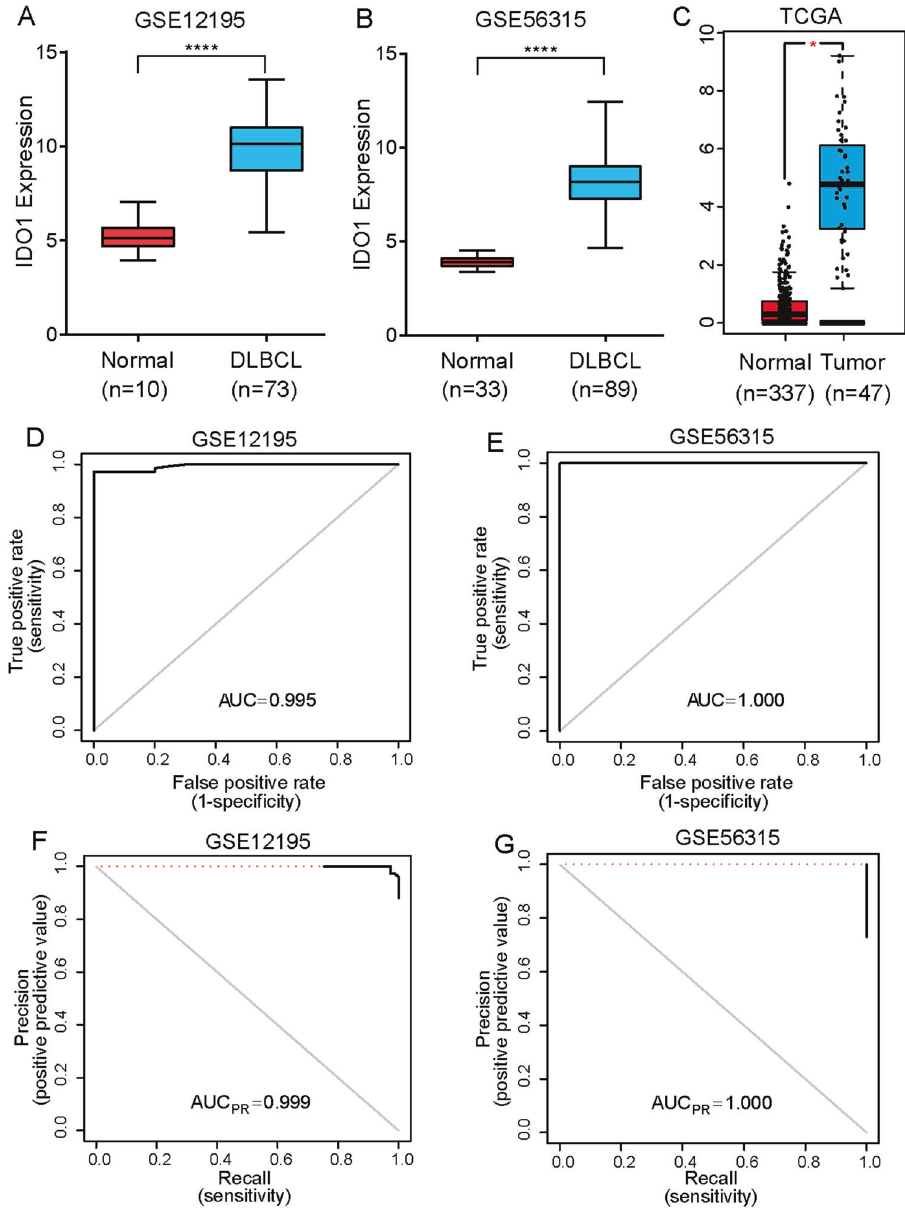
Fig. 1 DLBCL datasets revealed that IDO1 was overexpressed in DLBCL and could be a predictive marker for DLBCL. A – C IDO1 expression in DLBCL and normal tissues from GSE12195 ( A ), GSE56315 ( B ), and TCGA DLBCL ( C ). D , E Receiver operating characteristic (ROC) curves calculated the sensitivity and speci fi city of the IDO1 expression level for the prediction of DLBCL in the GSE12195 ( D ) (AUC = 0.995) and GSE56315 ( E ) (AUC = 1.000) datasets. F, G PRC analysis calculated sensitivity and speci fi city of the IDO1 expression level for the prediction of DLBCL in the GSE12195 ( F ) (AUC = 0.999) and GSE56315 ( G ) (AUC = 1.000) datasets. Statistical analysis was analyzed with a two-sided student ’ s t-test. * P < 0.05 and **** P <